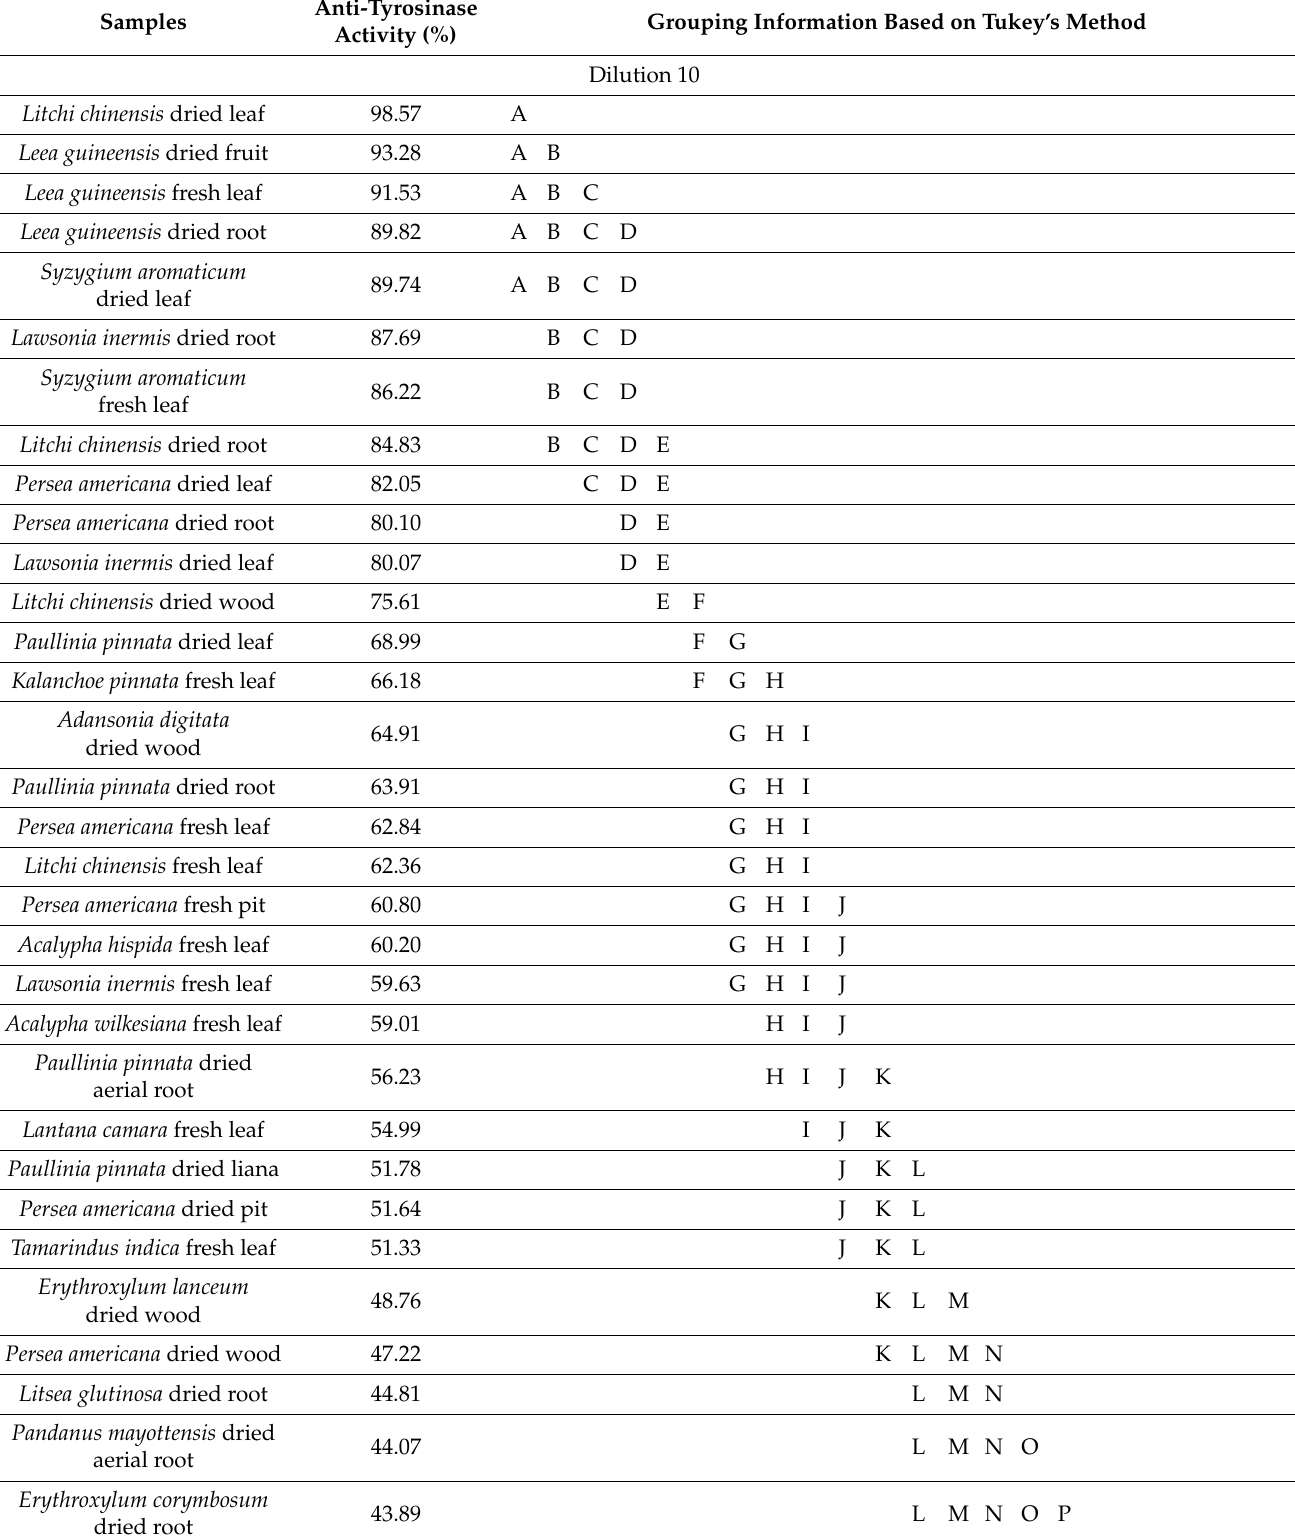
Table 4. Anti-tyrosinase activity results for the plant extracts diluted 10 and 100 times ( n = 3). Results were statistically analyzed using Tukey’s grouping test (confidence level: 95%), and the observed group classifications (A, B, C . . . . . . etc.) are shown in the present